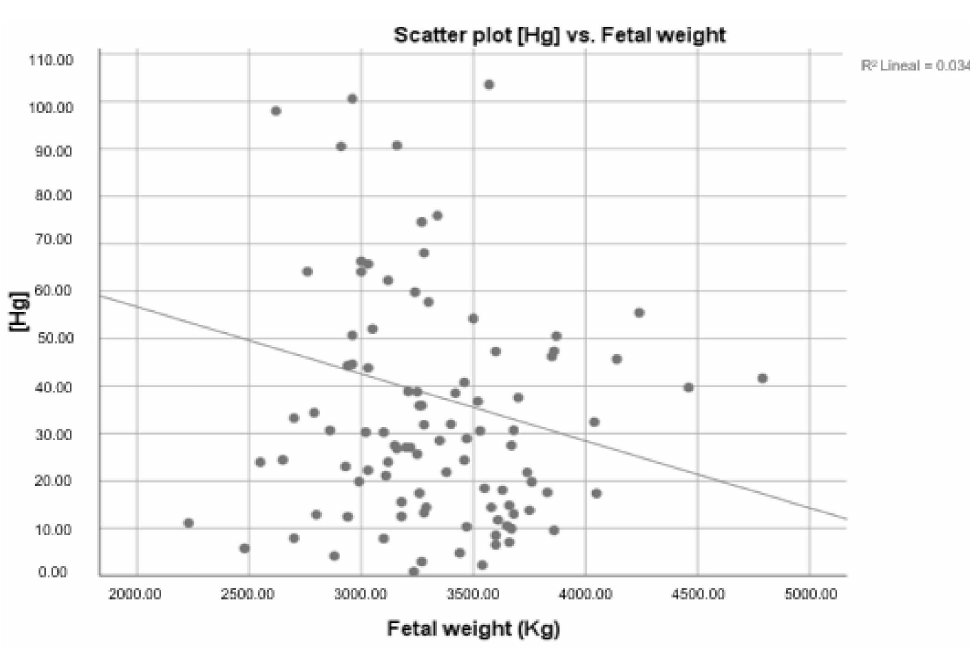
Figure 2. Hg placental concentration according to fetal weight.